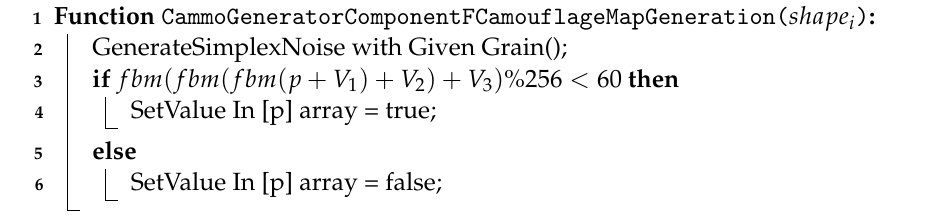
Algorithm 1: CammoGenerator component—camouflage map generation func- tion.